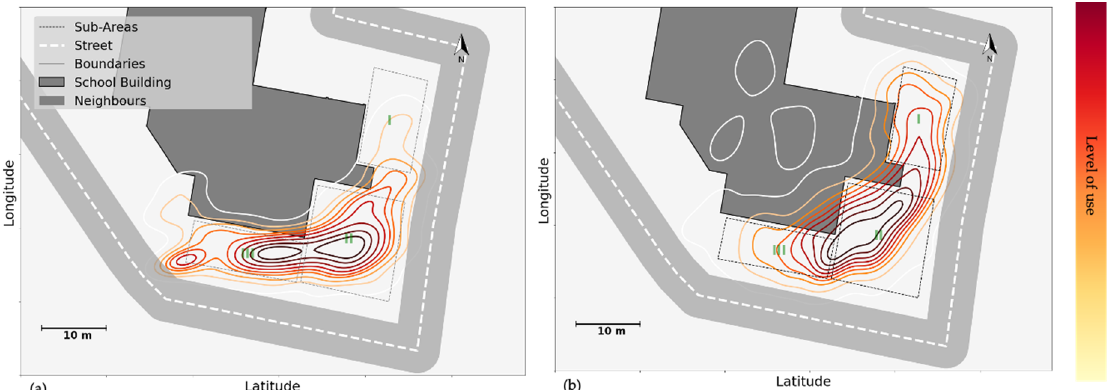
Figure 10. The use of space by cyclist children in school A (a) with restriction (b) without restriction from the break supervisor. The level of use is analysed via GPS data, and obtained contours are colour coded from the lowest level of use to the highest following the colour bar (from yellow to red).